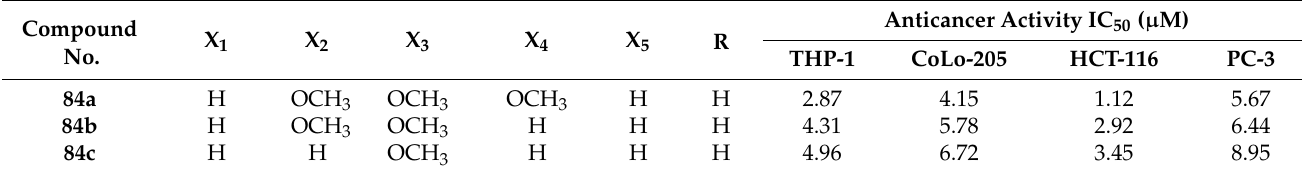
Figure 80. Structure of curcumin ‐ pyrimidine derivatives ( 83 ).